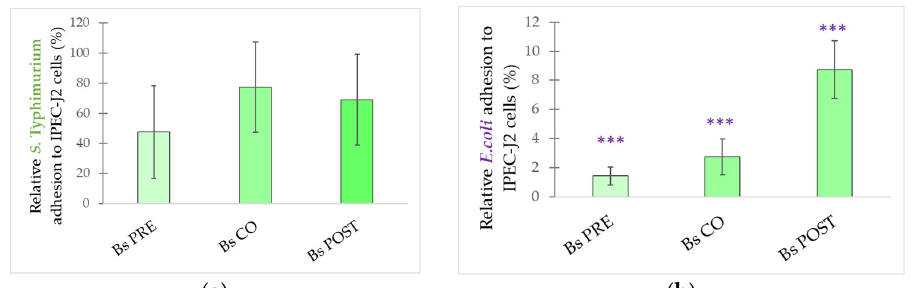
Figure 11. Inhibitory effect of B. subtilis on S. Typhimurium ( a ) and E. coli ( b ) adhesion to IPEC-J2 cells. S. Typhimurium and E. coli adhesion inhibitions were determined upon incubation with B. subtilis added 1 h before (pre-treatment), at the same time as (co-treatment), and 1 h after (post- treatment) the addition of S. Typhimurium and E. coli , respectively. B. subtilis was added in 10 8 CFU/mL. Bs PRE : pre-treatment with B. subtilis 10 8 CFU/mL + E. coli or S. Typhimurium 10 6 CFU/mL; Bs CO : co-treatment with B. subtilis 10 8 CFU/mL + E. coli or S. Typhimurium 10 6 CFU/mL; Bs POST : post-treatment with B. subtilis 10 8 CFU/mL + E. coli or S. Typhimurium 10 6 CFU/mL. Data are shown as means with standard deviations and expressed as relative adhesion, considering the mean value of only S. Typhimurium or E. coli treated cells as 100%. n = 6/group. Significant differ- ence: *** p ≤ 0.0001, in purple: compared with treatment with E. coli .